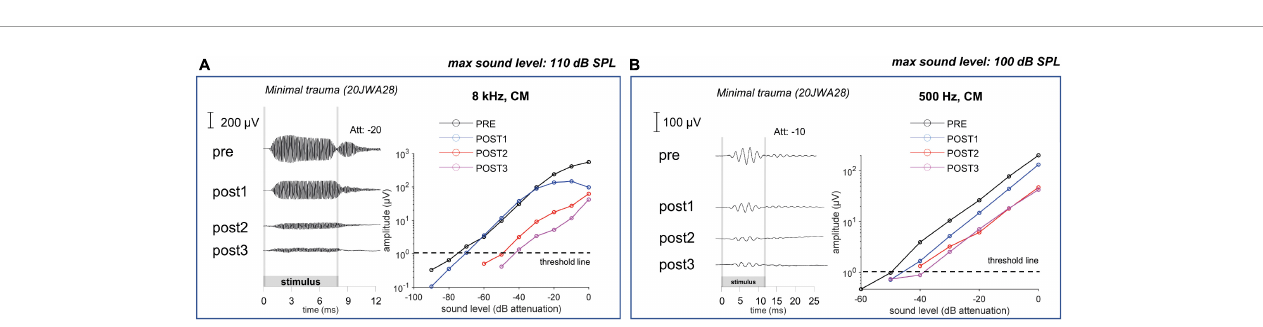
FIGURE11 The cochlear microphonic responses to an 8 kHz (A) and 500 Hz (B) tone of one individual minimal trauma animal are shown for all 4 stages at ∼ 90 dB SPL. The graphs show the input/output curve, with threshold criterium of 1 µ V amplitude (peak-to-peak). The highest threshold shifts are seen after electrode insertion (POST1) to an 8 kHz tone, however also threshold shifts occurred for the responses to a low frequency tone.